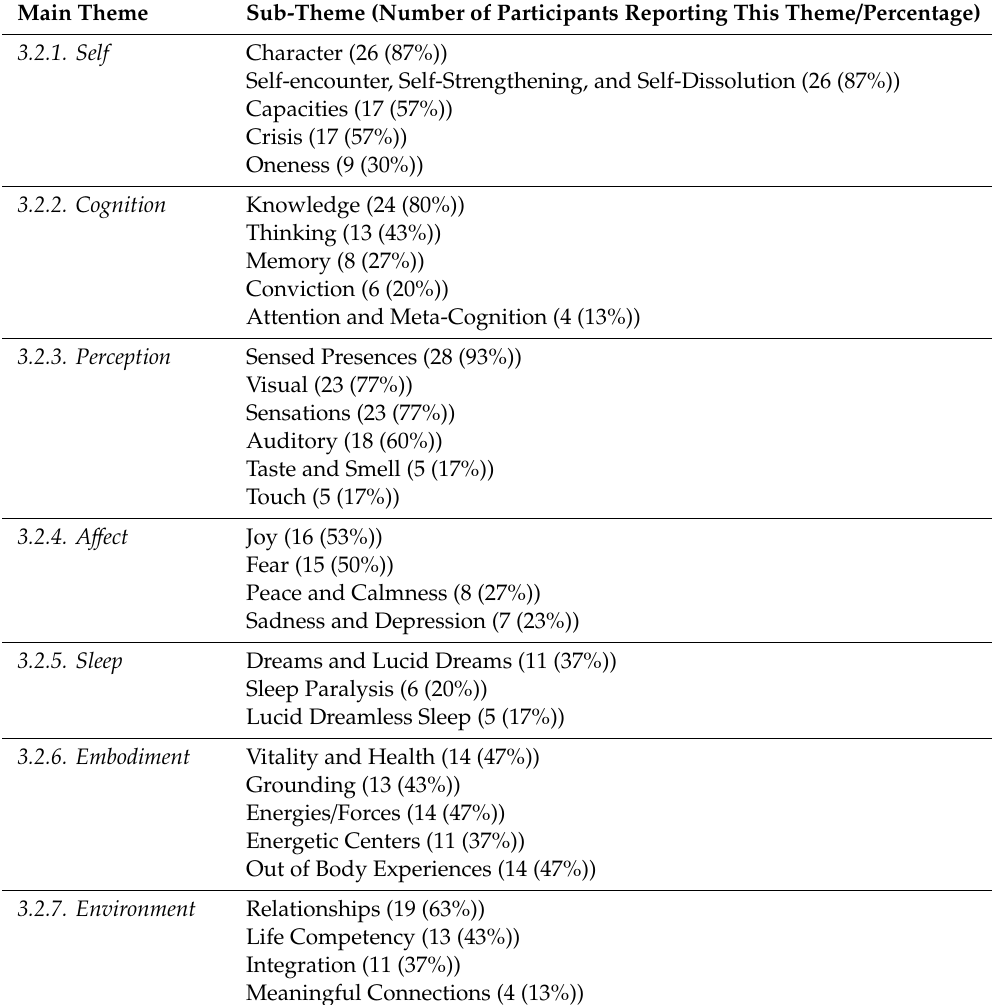
Table 3. Overview of Themes and Prevalence of Themes in the study sample (N =